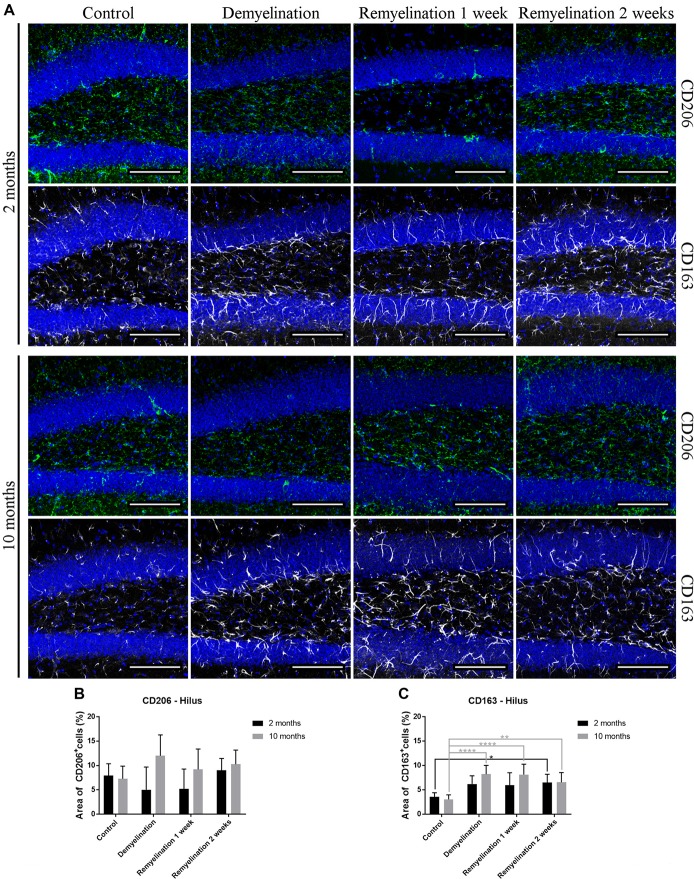
Age-related differences in cuprizone-induced increase of CD163 in the hilus of the hippocampal DG, while CD206 is unchanged. (A) CD206 (green) and CD163 (white) labeling. Cell nuclei are stained with DAPI (blue). (B) In both age groups, de- and remyelination did not significantly affect CD206 staining. (C) In the middle-aged group, CD163 was significantly upregulated during de- and remyelination. In the younger group, the CD163 increase was only significant 2 weeks after remyelination. Values are shown as means + SD (n = 6 per group). Statistical significance was evaluated using a two-way ANOVA followed by a Tukey’s post hoc test (C). The p-values are indicated in the graphs: treatment effects within the same age group: *p < 0.05, **p < 0.01 and ****p < 0.0001. Bars: (A) 100 μm.